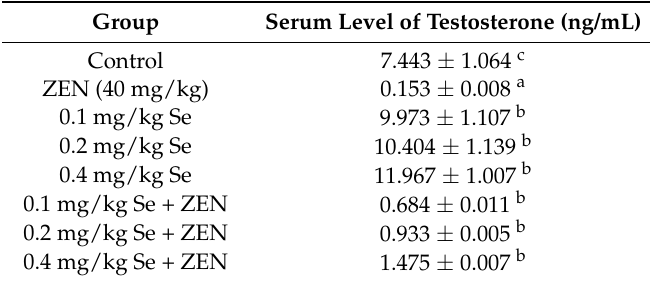
Table 2. Effect of Se on serum level of testosterone in mice induced by